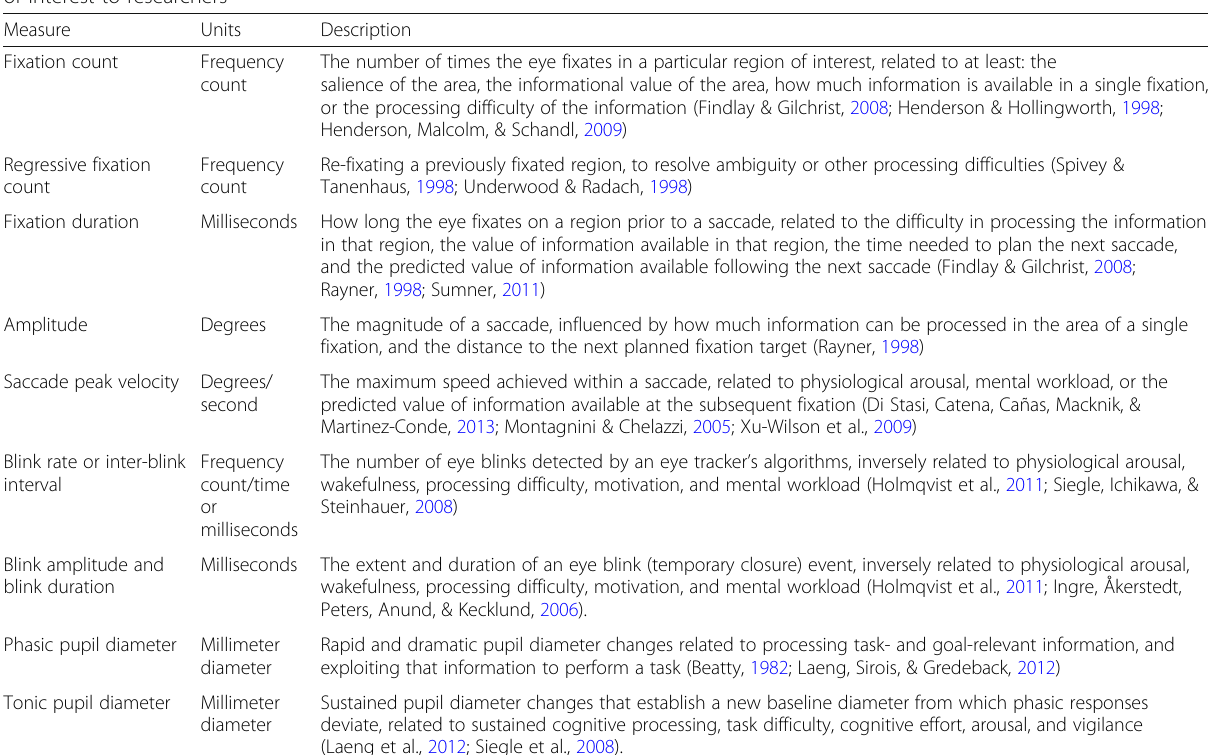
Table 1 A taxonomy relating commonly used eye-tracking metrics and their respective units to perceptual and cognitive processes of interest to